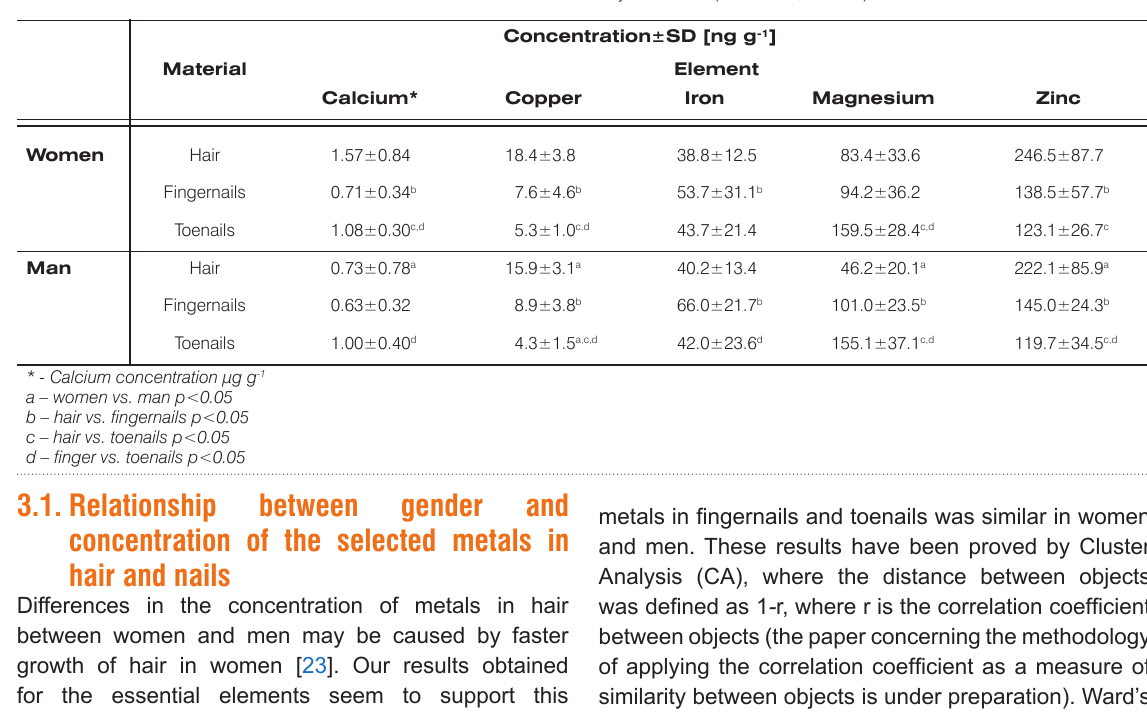
Figure 3. Projection of variables (Cr, Ni, Cd) on the plane of PC1 (52.17%) and PC2 (29.18%) principal components. Table 4. Mean concentration of essential metals in hair and nails of healthy volunteers (24 women; 18